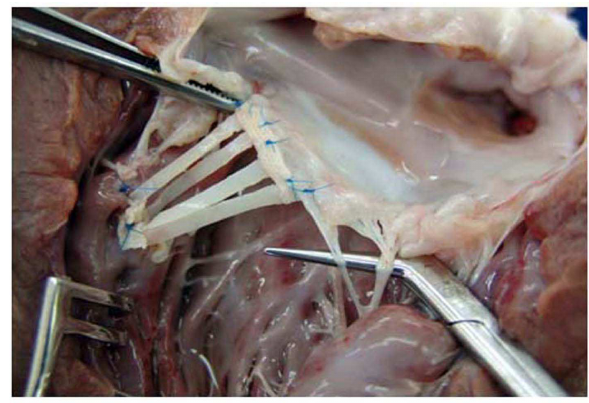
Fig. 9 – Anatomical aspect of the implantation of the prosthesis in an open bovine left ventricle